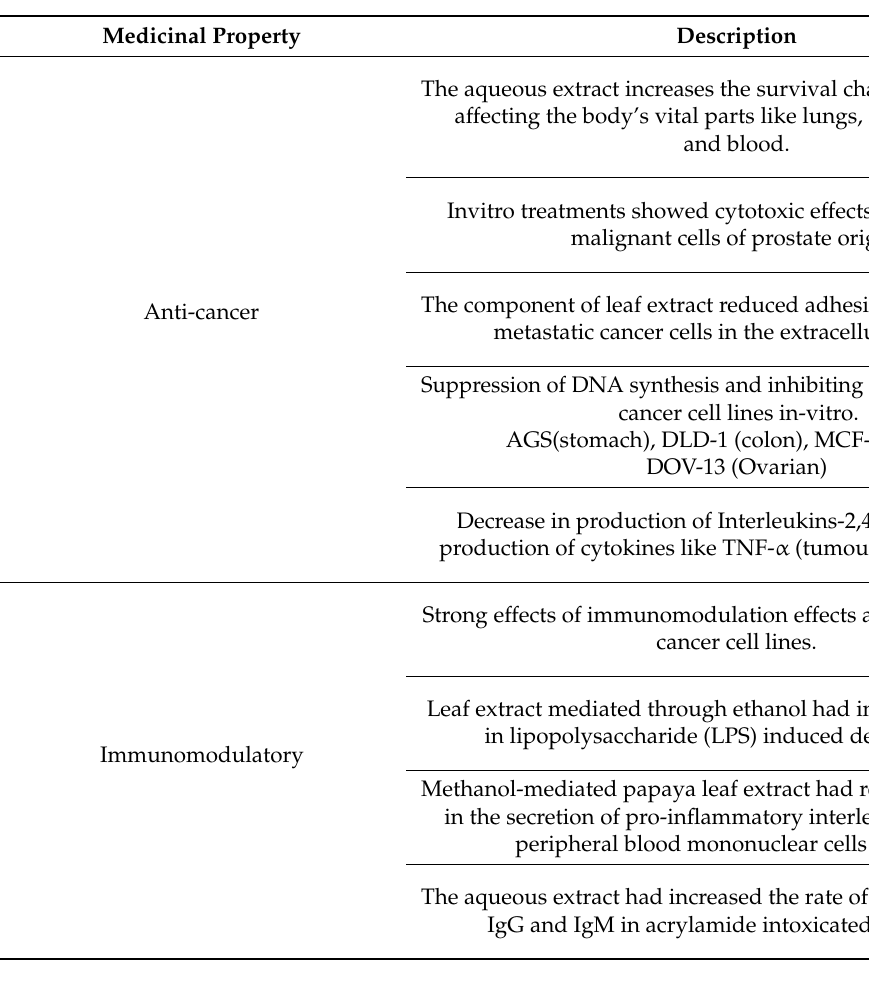
Table 1. Pharmacological properties of Carica papaya